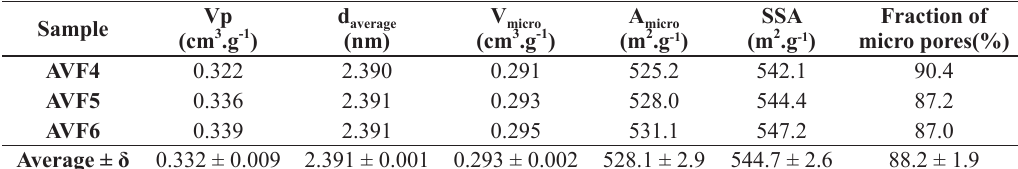
Parameters of the porous structure of AVFs activated under a heating rate of 5 °C.min -1 .